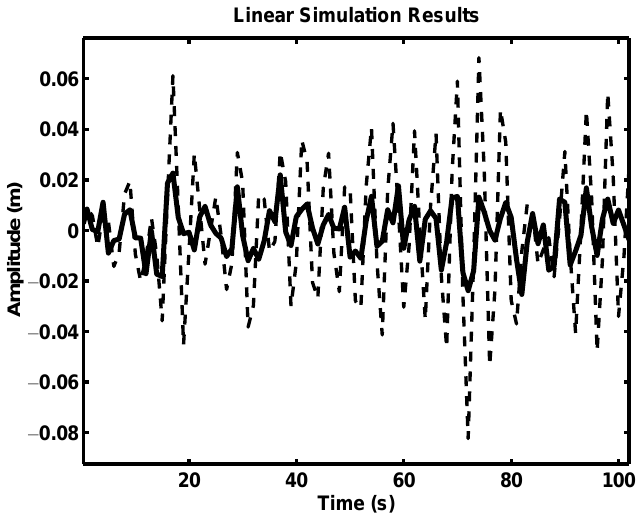
Fig. 8. Beam free-end displacement. Dashed line – without control. Solid line – controlled (reduced order).